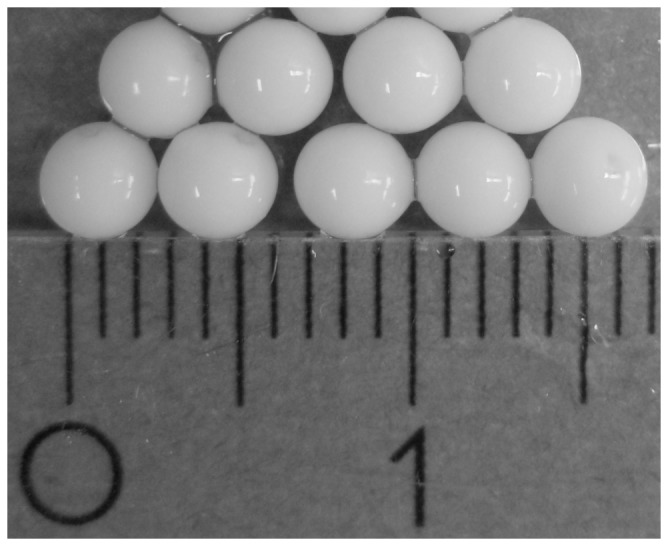

S. cerevisiae encapsulated in alginate chitosan capsules.Capsules full of cells at the time of sampling for proteome analysis. Major unit of the ruler is in centimetres.